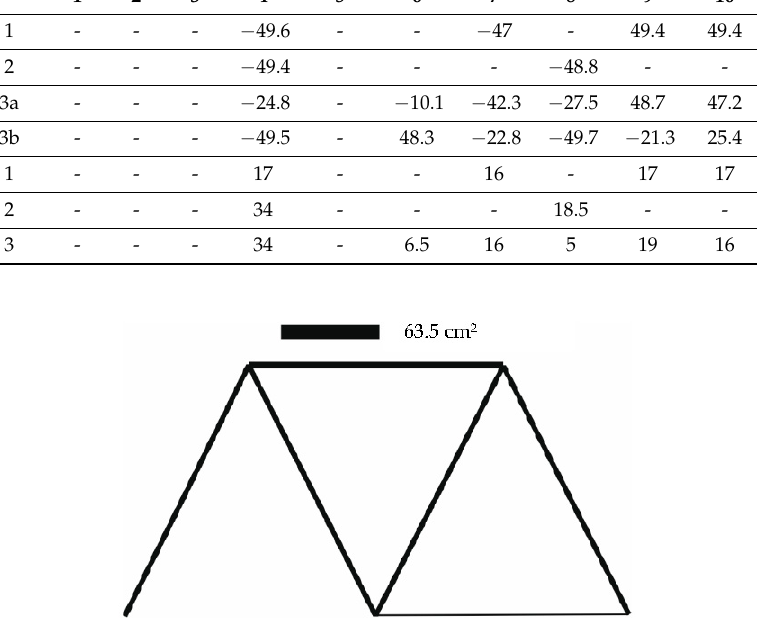
Figure 11. Initial 15 bar structure optimized for load case 1.